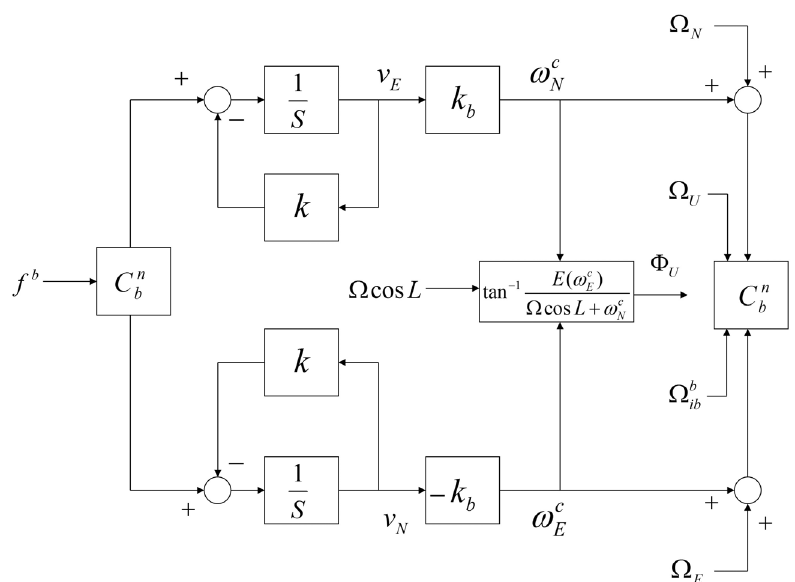
, ω c ) are calculated N E